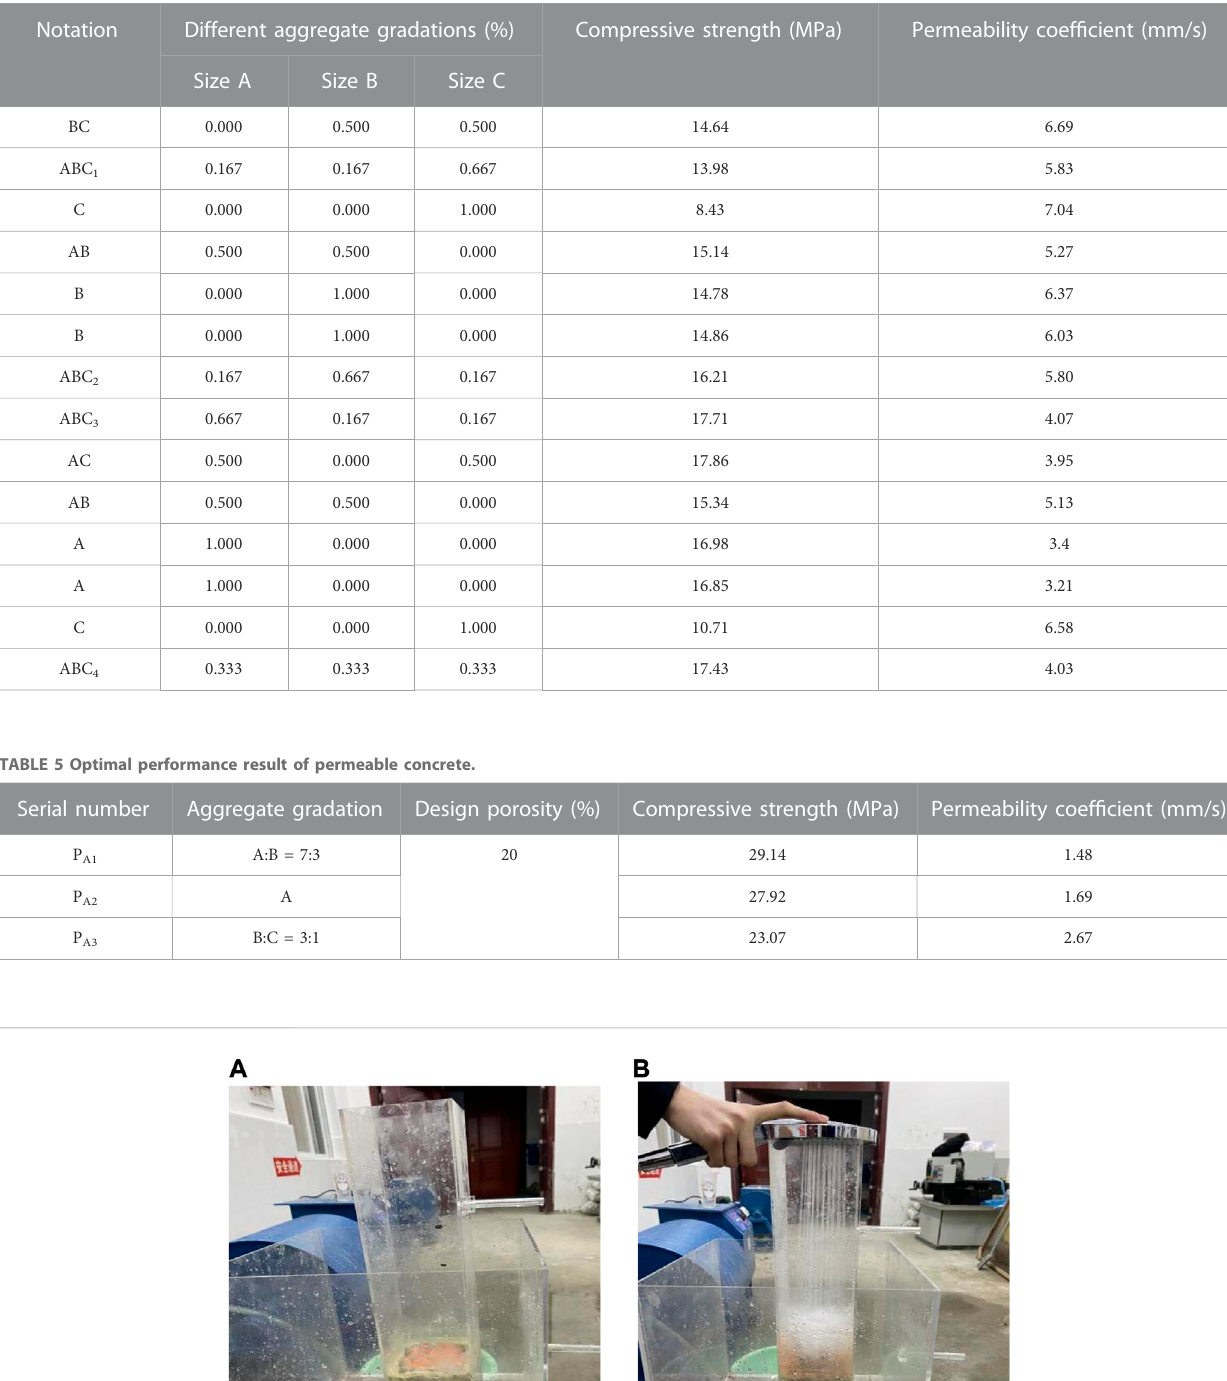
TABLE 4 Simplex centroid design point of aggregate gradation.